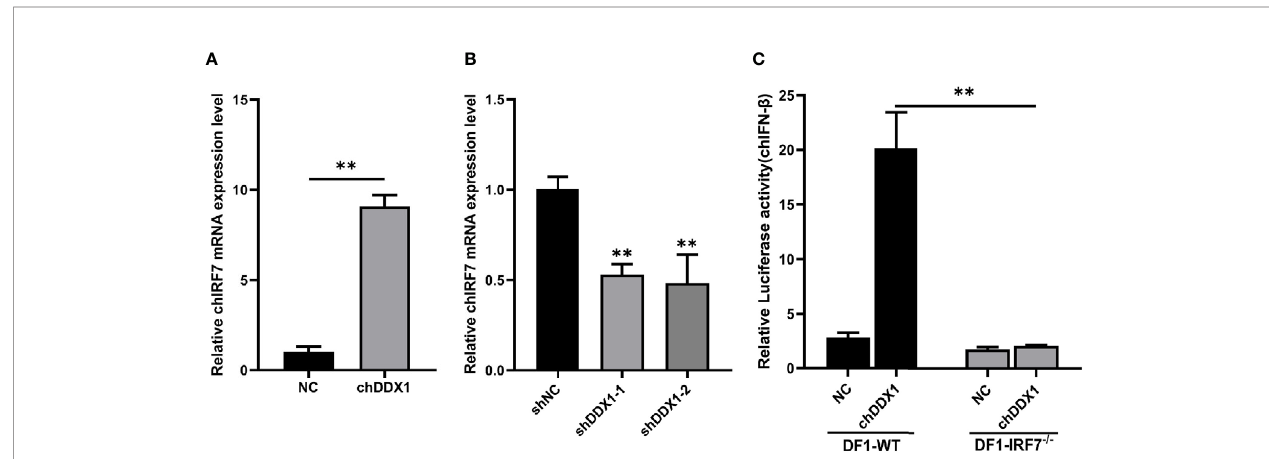
FIGURE 7 | chDDX1 activated IFN signaling via the chIRF7 pathway. (A) Relative mRNA levels (qRT-PCR) of chIRF7 in DF-1 cells transfected with p3×FLAG-14- chDDX1 or p3×FLAG-14. (B) IRF7 expression (qRT-PCR) in DF-1 cells transfected with RNAi plasmids (shDDX1-1, shDDX1-2, or shNC). (C) chDDX1 expression in